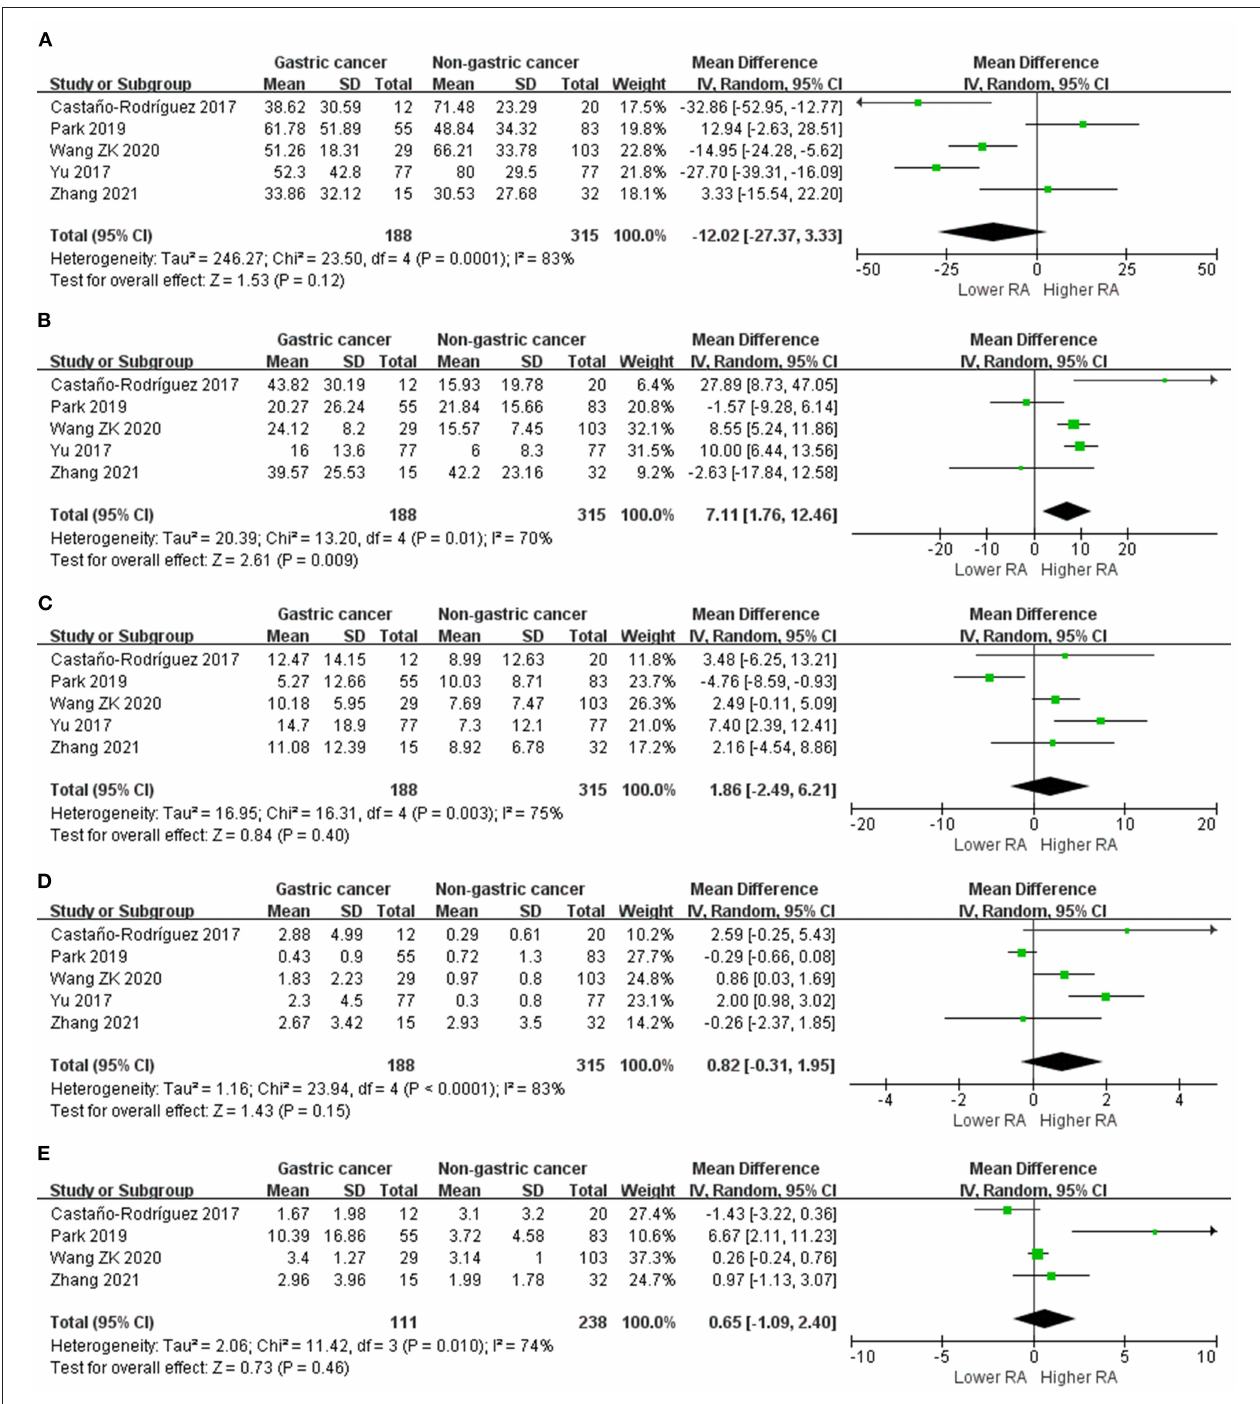
FIGURE 3 | Forest plot for changes in relative abundance of bacterial phyla including Proteobacteria (A) , Firmicutes (B) , Bacteroidetes (C) , Fusobacteria (D) , and Actinobacteria (E) between gastric cancer and non-gastric cancer groups.